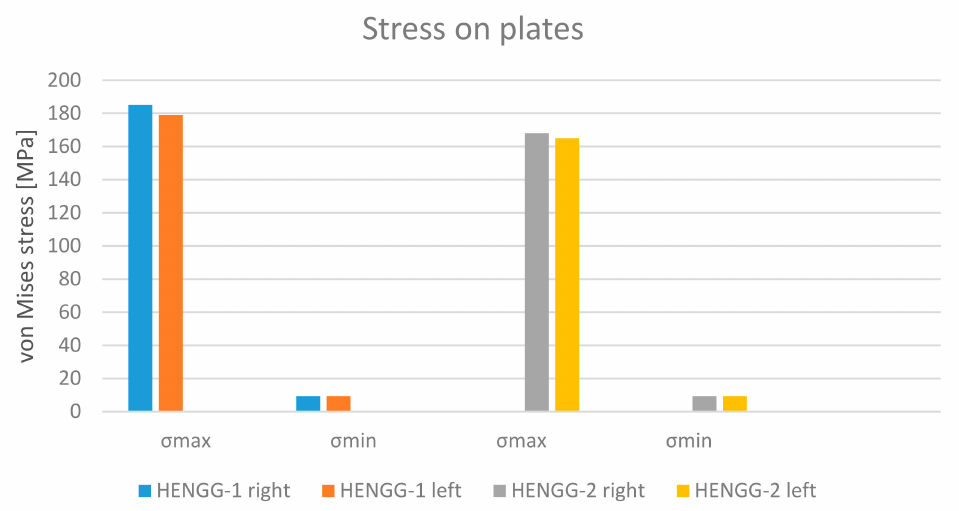
Figure 10. The von Mises stress values (in MPa).